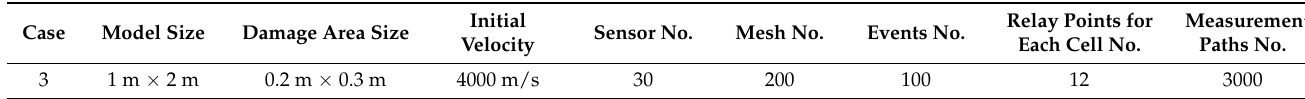
Figure 10. Original distribution for the damage target in case 3. Table 4. Model information for case 3.